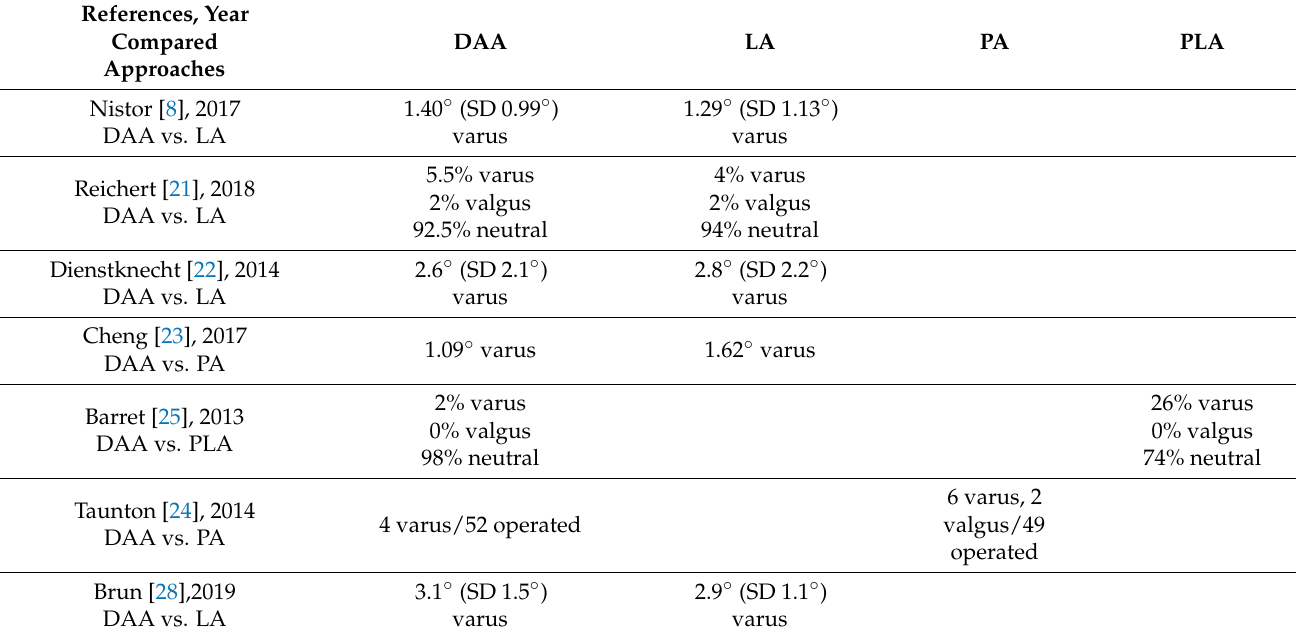
Table 4. Femoral stem alignment in analyzed studies.